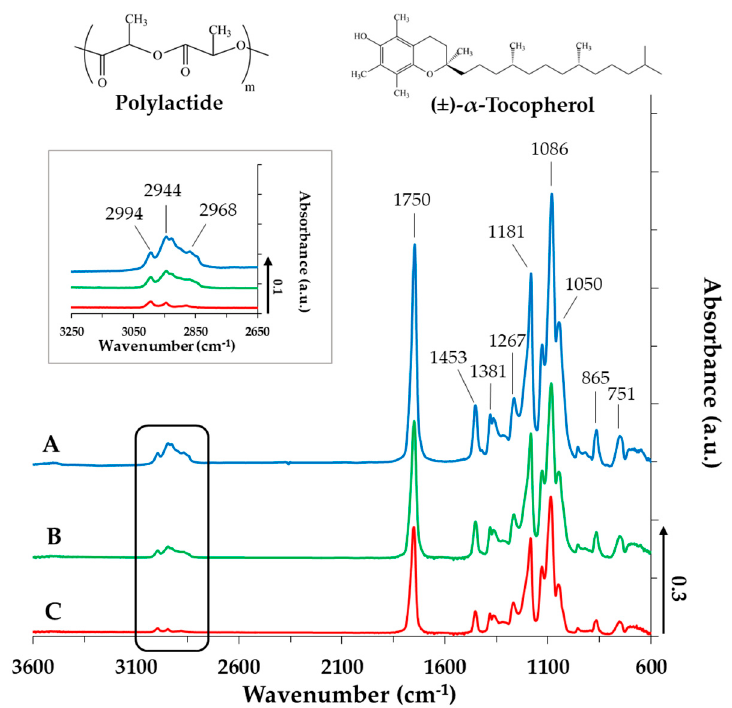
Figure 4. IR spectra of the TP-loaded PLA NPs (A: c TP = 0 mg · mL − 1 ; B: c TP = 2.5 mg · mL − 1 ; C: c TP = 5 mg · mL − 1 , c PLA = 10 mg · mL − 1 and c PLUR = 0.1 mg · mL − 1